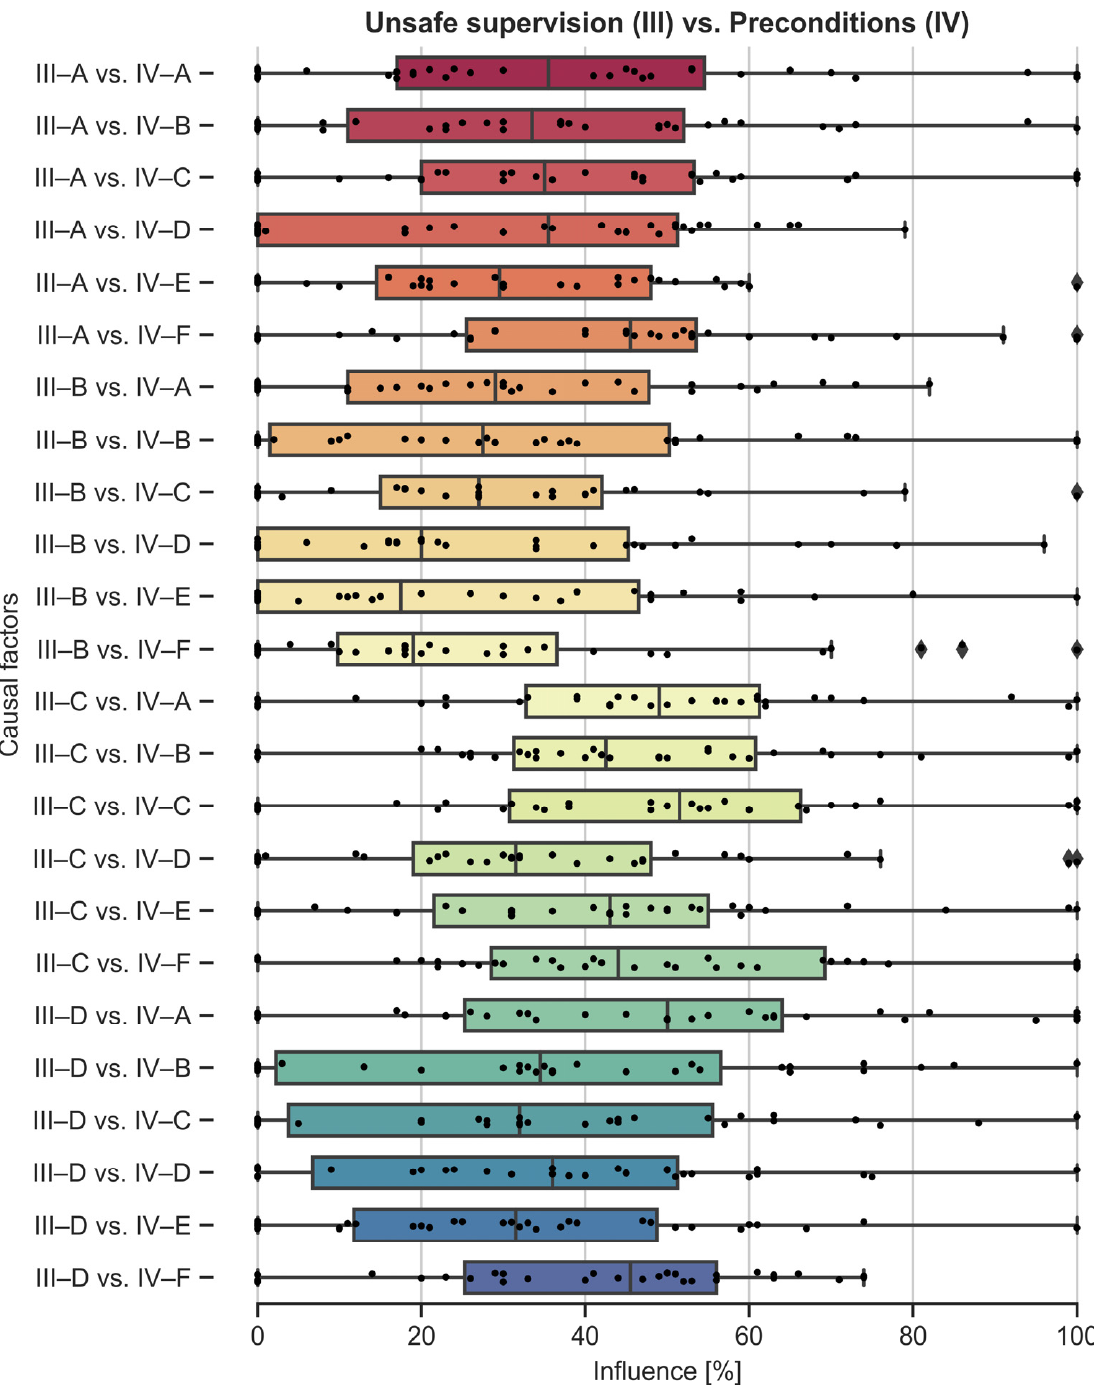
Figure 5. Box plots depicting the statistical analysis of data obtained on stage 3.